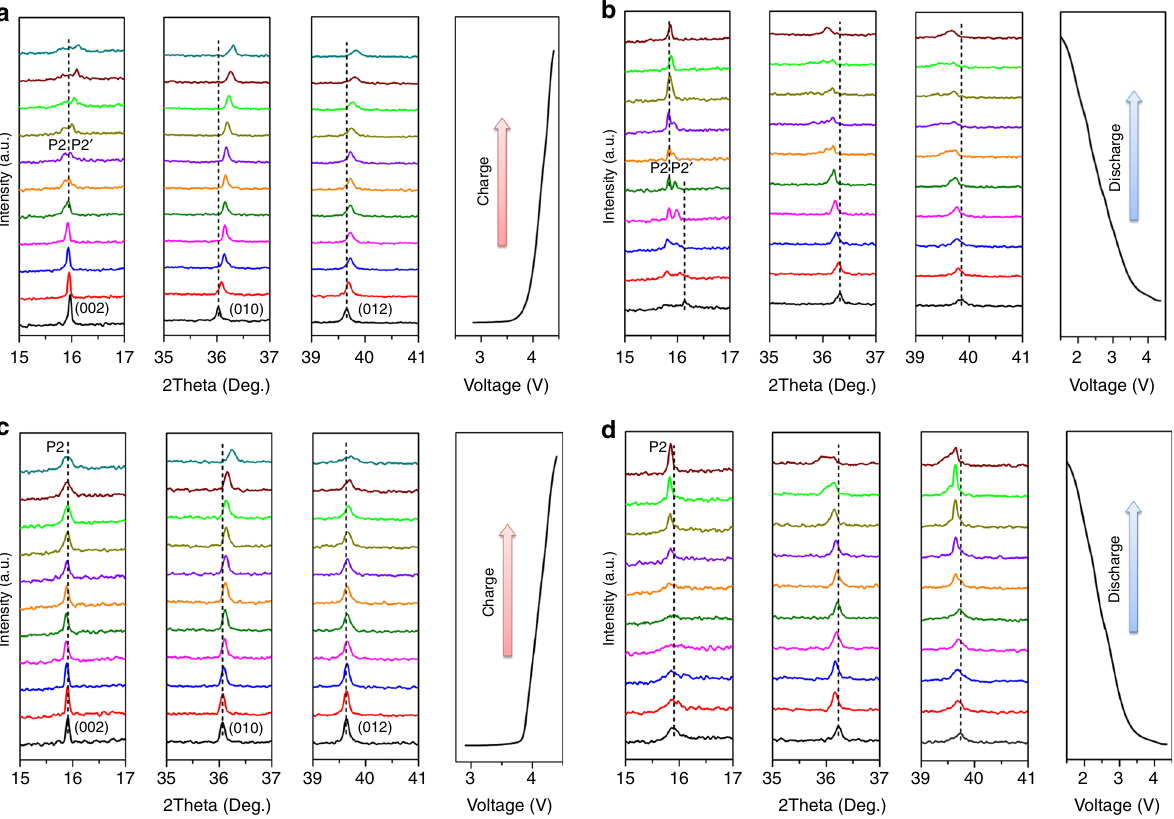
Fig. 6 The phase changes of NLMO and NLMO-Zn during the 1st cycle. In situ XRD patterns of NLMO ( a , b ) and NLMO-Zn ( c , d ) during the 1st charge/ discharge are